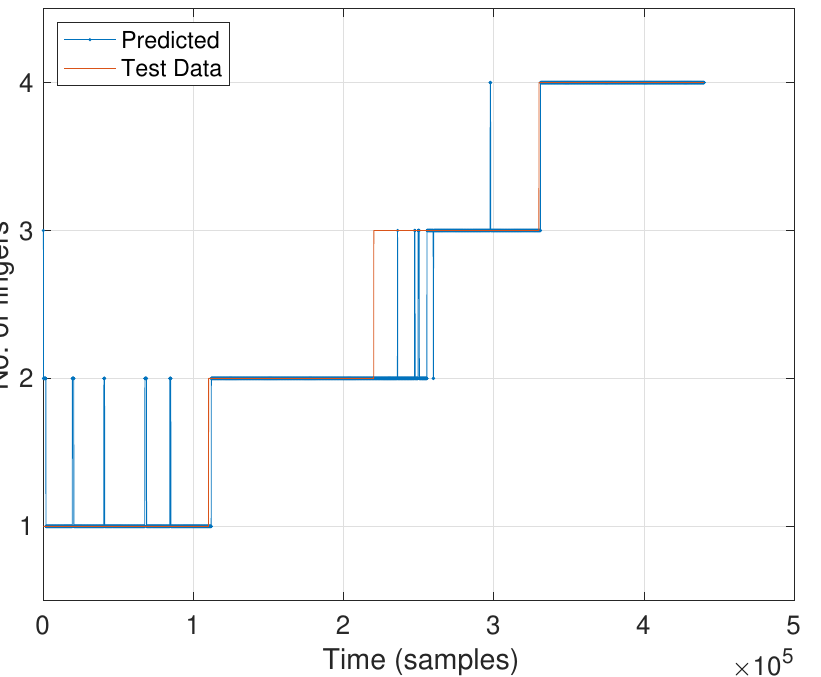
Figure 8. Predicted versus actual number of fingers in